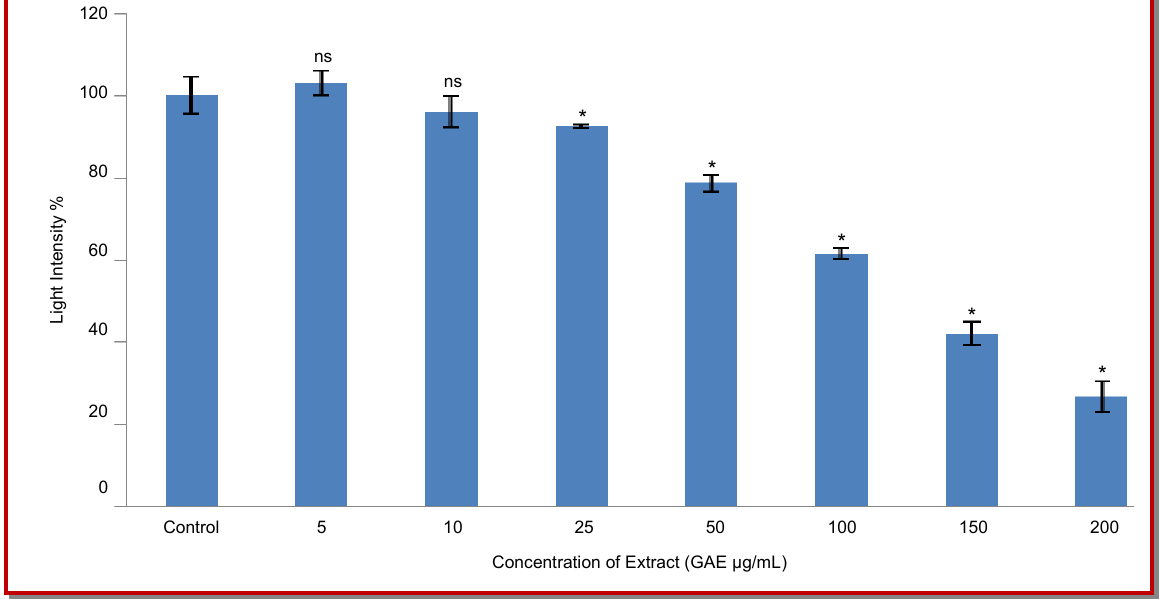
Figure 3: Effect of different concentration of extract in terms of GAE on U-2 osteosarcoma cell viability. The value was average of three samples with standard deviation as error bars. *represents the significant difference and ns means non-significant compared to control with p<0.05 using Dunnet multiple comparison test